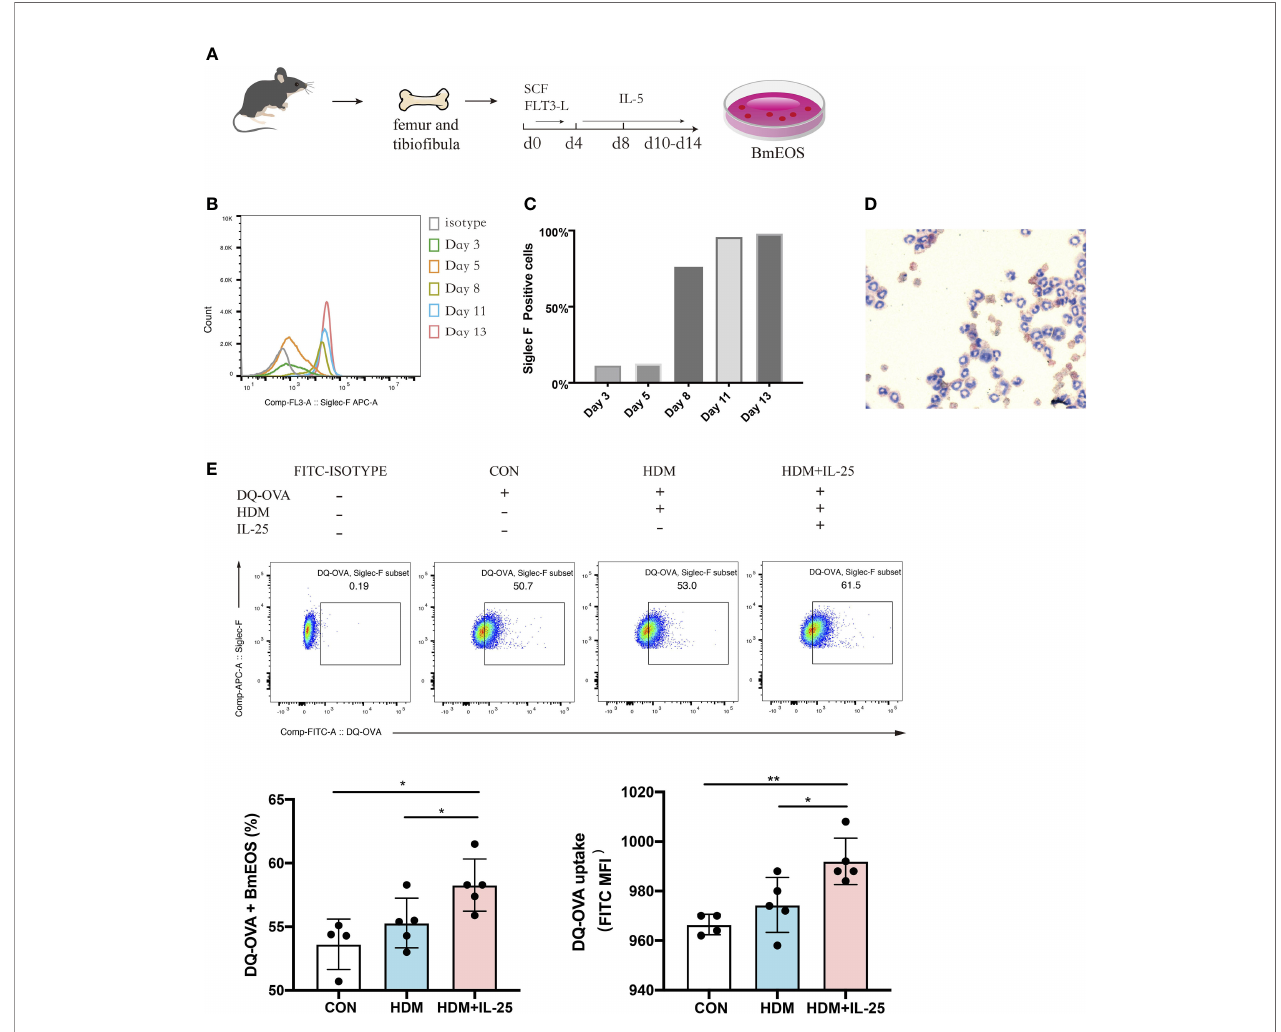
FIGURE 6 | IL-25 promotes antigen uptake by BmEOS. (A) Flowchart of isolation and culture of BmEOS. (B – D) Identi fi cation of BmEOS. Histogram of Siglec-F expression at indicated times of mouse BmEOS culture (B) . Flow cytometry analysis of the percentages of Siglec-F positive BmEOS using isotype control and anti- Siglec-F AF647-conjugated antibody (C) . Light microscopic image of BmEOS at culture day 11, Diff-Quick staining (D) . (E) At day 10~13, BmEOS were treated with or without HDM in the absence or presence of IL-25 for 48 h. During the last 12 h, DQ-OVA was added. The percentages of DQ-OVA + BmEOS and MFI of DQ-OVA were analyzed by fl ow cytometry. Representative graphs, statistical data, and MFI values are shown. Cells without DQ-OVA were set as isotype. n = 4 ∼ 5, unpaired Student ’ s t test (E) , *p < 0.05, **p <